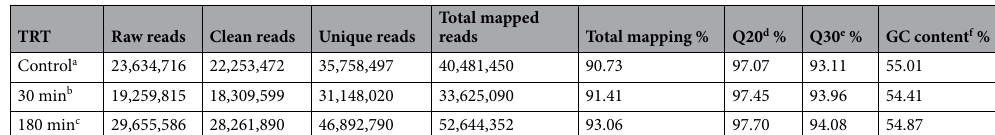
Table 1. Summary of sequencing results of blood samples from goats subjected to transportation stress treatment (TRT). a Not transported but held in pens; b Transported for 30 min; c Transported for 180 min; d Phred values greater than 20 base number contain the percentage of total bases; e Phred values greater than 30 base number contain the percentage of total bases; f Percentage of guanine and cytosine base numbers of total bases.